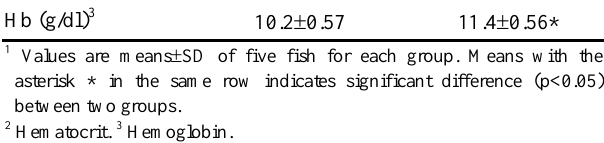
Table 5. Hematological characteristics of juvenile sterlet sturgeon fed diets for 5 wks 1